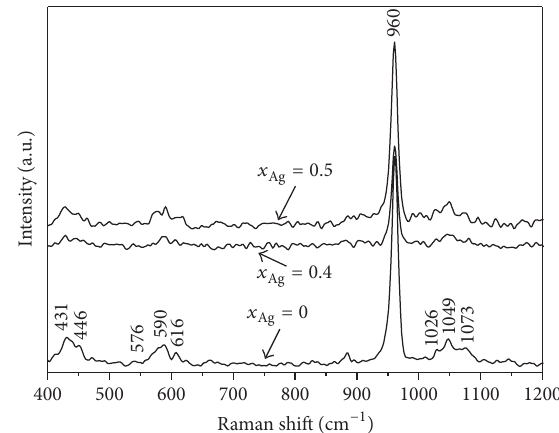
F 3: Transmittance infrared spectra of the Ag:HAp samples F 4: Raman spectra of the Ag:HAp samples synthesized with = 0, 0.4, and 0.5. synthesized with = 0, 0.4, and 0.5. Ag Ag 𝑥𝑥 𝑥𝑥 band at 1073 cm , and have weak intensities and were not detected [32]. Water vibrational band positions not obscured by the PO modes give rise to weak intensity stretching and bands, but they have 𝜈𝜈 4 𝜈𝜈 2 4